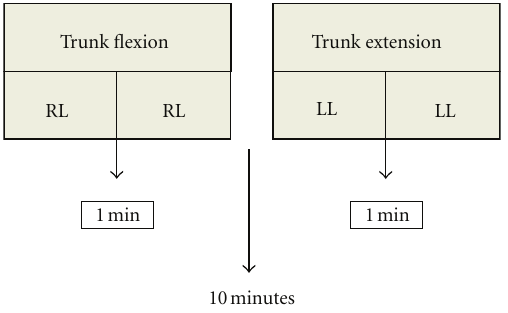
Figure 3: Performed motion sequence. RL: right limb; LL: left limb.